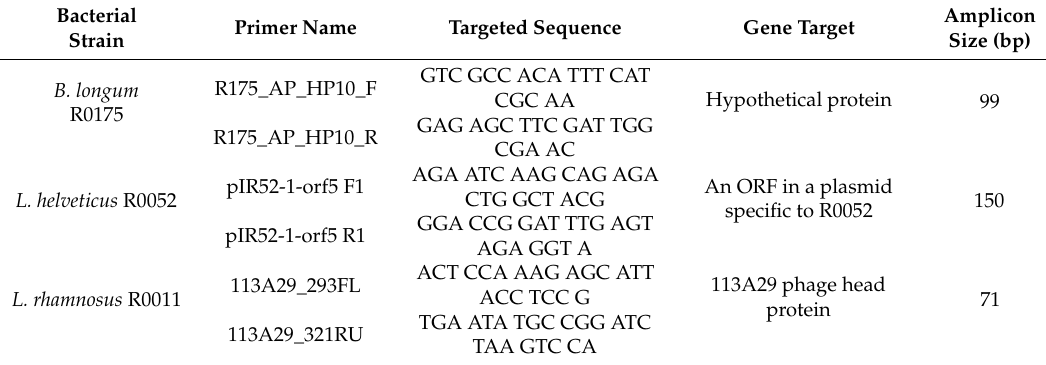
Table 1. Primer and target sequences for qPCR